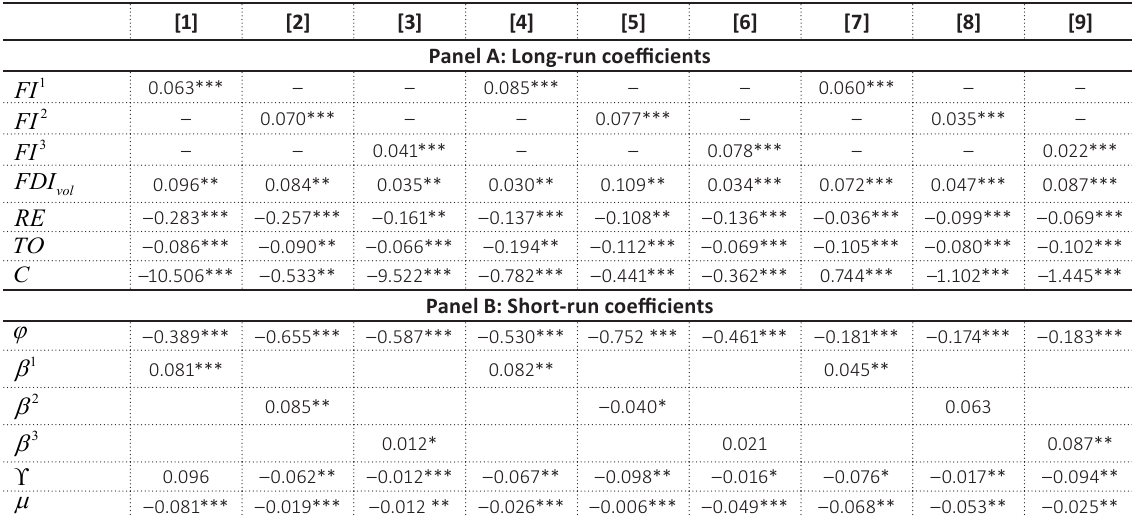
Table 6. Long-run and short-run model